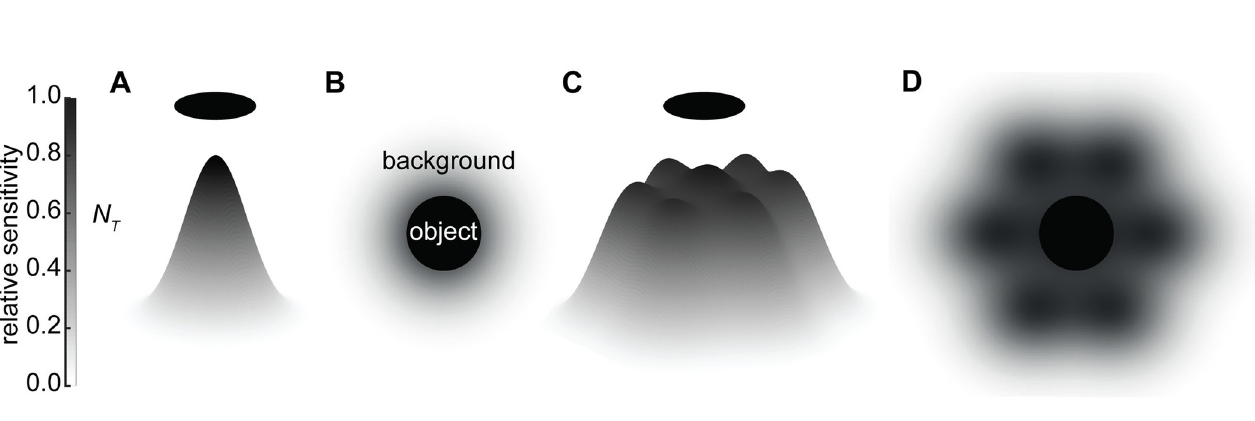
Fig 3. The receptive fields of target channels comprising (A) a single ommatidium or (C) seven summated ommatidia viewing an extended dark object against background radiance. (B, D) Top-down views of the receptive fields in (A) and (C) showing the object obscuring parts of the receptive field (black circle) and the remaining parts of the receptive field that view the background. Grey levels represent the relative sensitivity of the receptive fields (darker indicating greater sensitivity).